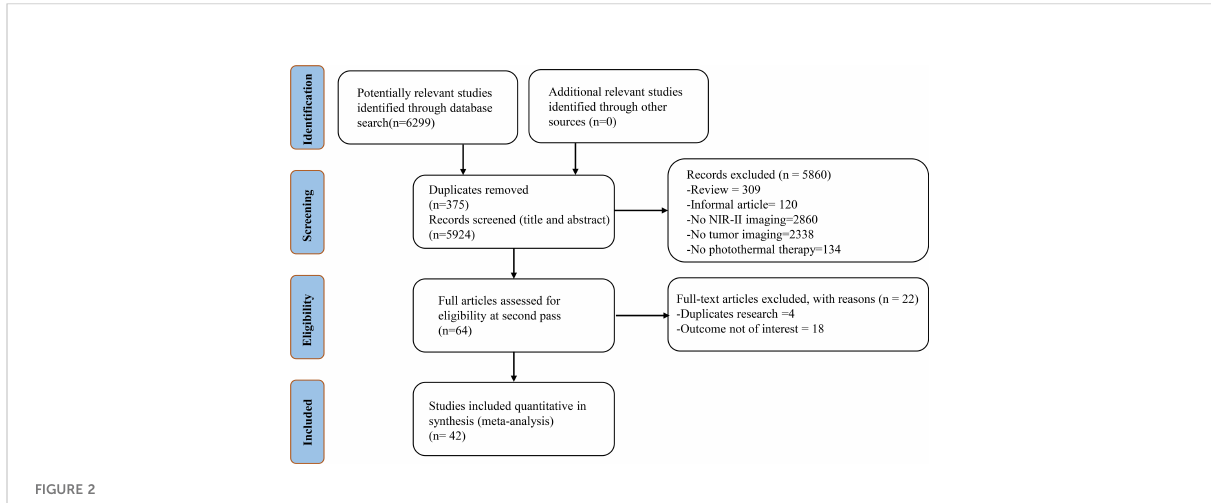
FIGURE 2 Flow chart of study